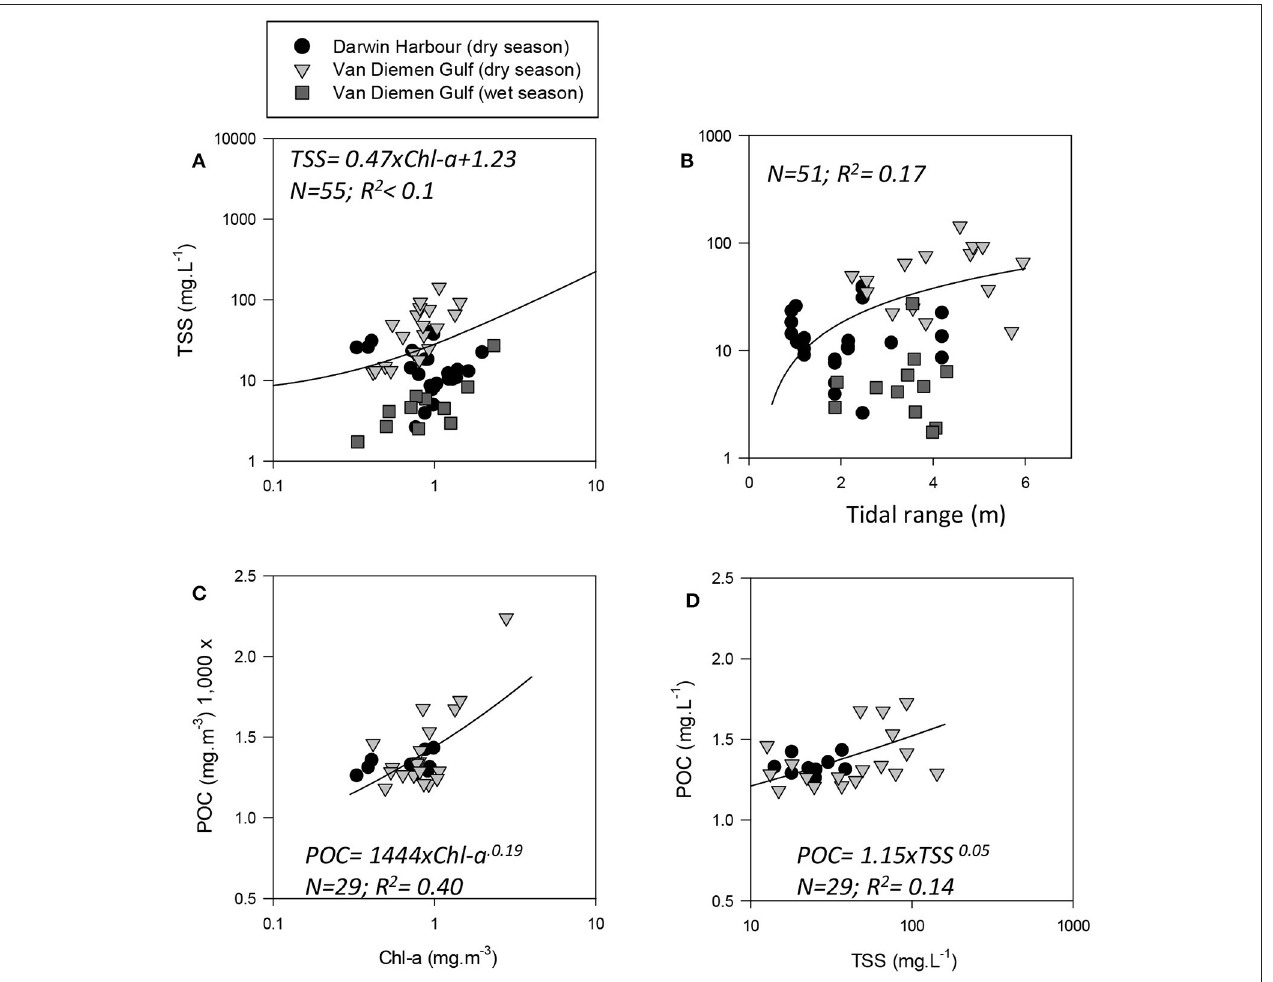
FIGURE 3 | Relationships between: (A) TSS and Chl-a, (B) TSS and tidal range (note: × is linear), and POC as a function of (C) Chl-a and (D) TSS.